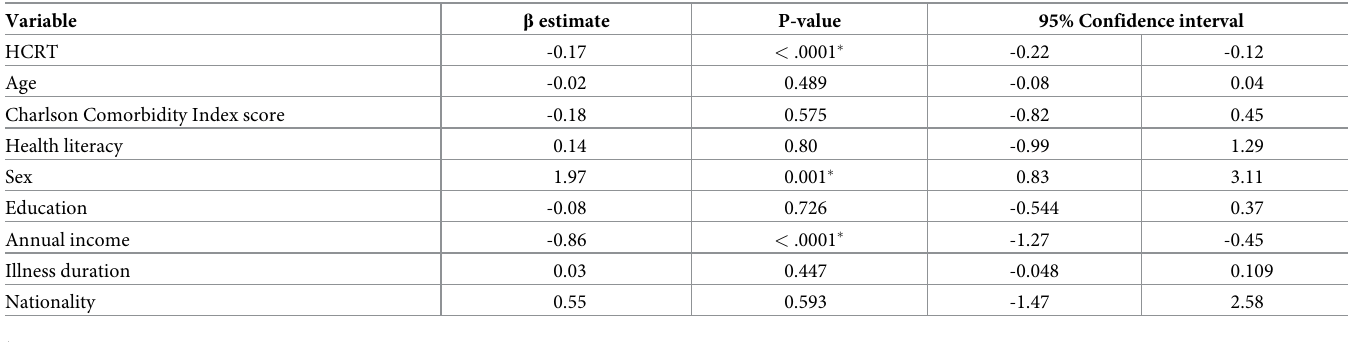
Table 3. Multiple linear regression for the association between generalized anxiety disorder-7 (GAD-7) scores and health care relationship (HCR) trust scores.